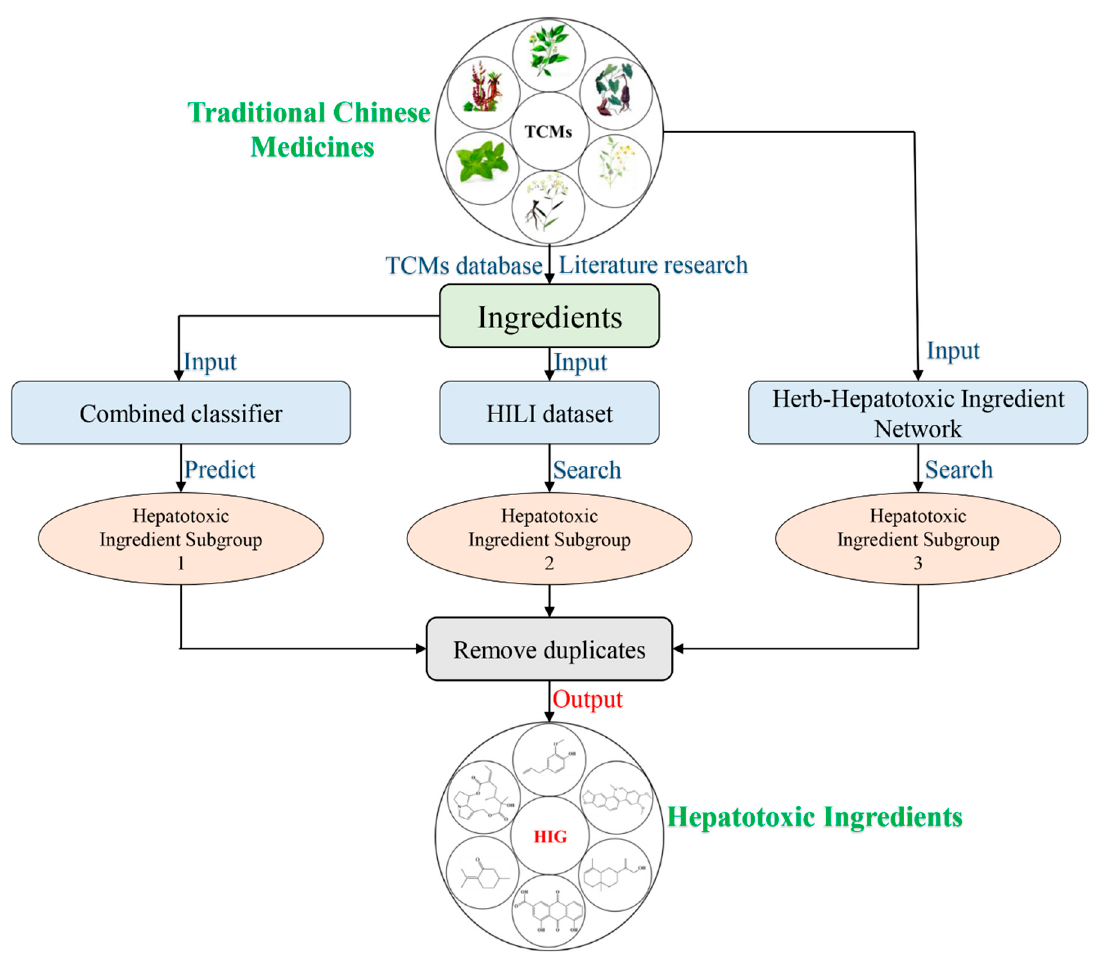
Figure5. Diagramofthecomputationaltoxicologyapproachtoidentificationthehepatotoxicingredients Figure 5. Diagram of the computational toxicology approach to identification the in Traditional Chinese Medicines hepatotoxic ingredients in Traditional Chinese Medicines (TCMs).